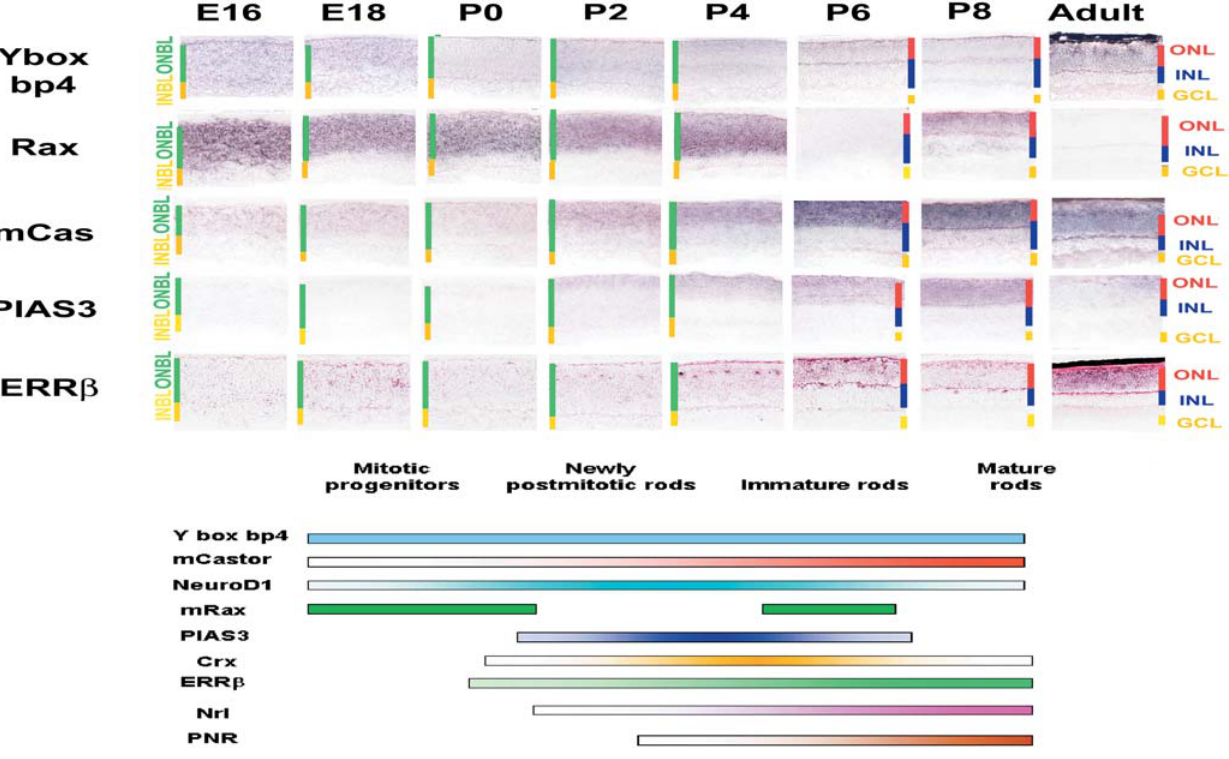
Figure 4. Transcription Factor Cascade in Photoreceptor Development Transcription factors that are selectively expressed in developing rods (and possibly cones as well) are shown. The schematic diagram integrates gene expression data from previously identified photoreceptor-enriched transcription factors and from genes explored in this study. The genes shown are Mm.193526/Yboxbp4, Mm.3499/Rax, Mm. 89623/mCas, Mm.1635/PIAS3, and Mm.235550/ERR b . See Figure S6 for images of the developmental expression patterns of previously characterized transcription factors. Sections were from central retina. Cellular laminae of both the developing and mature retina are indicated with colored bars. All pictures were taken at 200x. See Table S5 for a full list of probes used. DOI: 10.1371/journal.pbio.0020247.g004